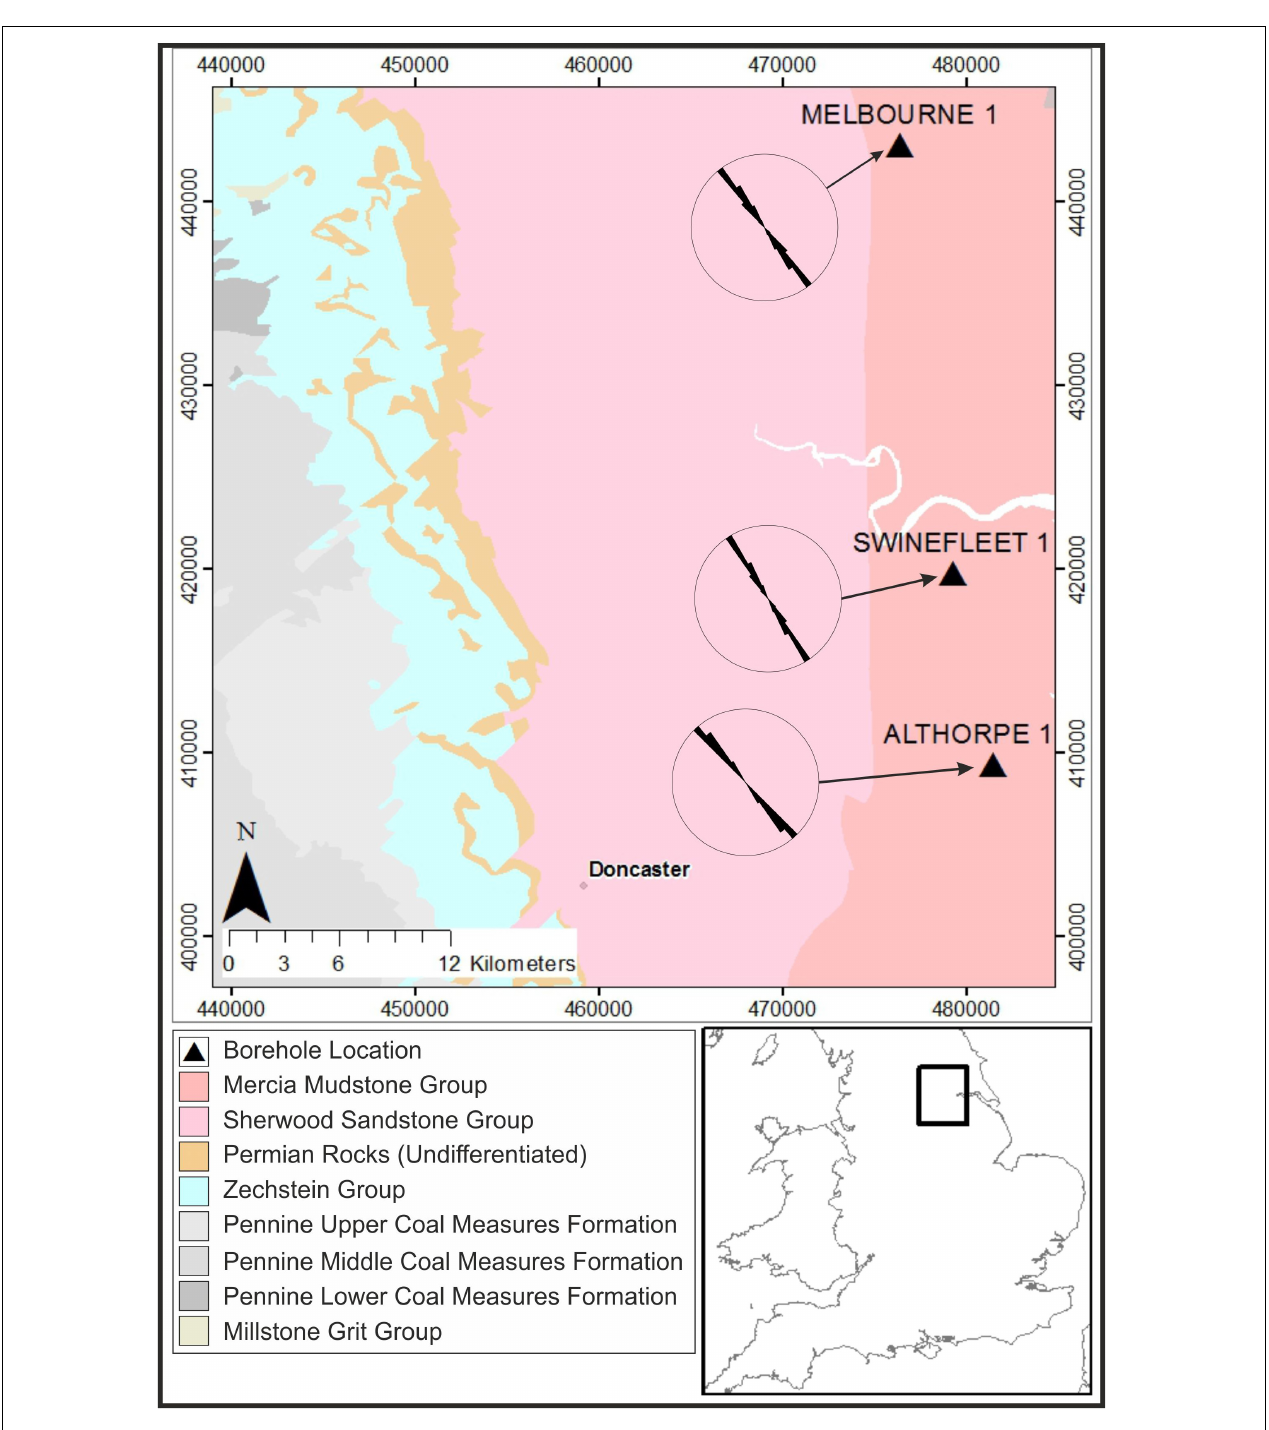
FIGURE 1 | Map showing the location of three boreholes in North Yorkshire with whole round drill core, conventional wireline logs and high resolution borehole imaging, bedrock geology, and rose diagrams showing S HMax orientations after Kingdon et al. (2016); see Table 1 for details. Locations are in British National Grid Contains Ordnance Survey data © Crown copyright and database rights 2019. Contains British Geological Survey materials ©NERC